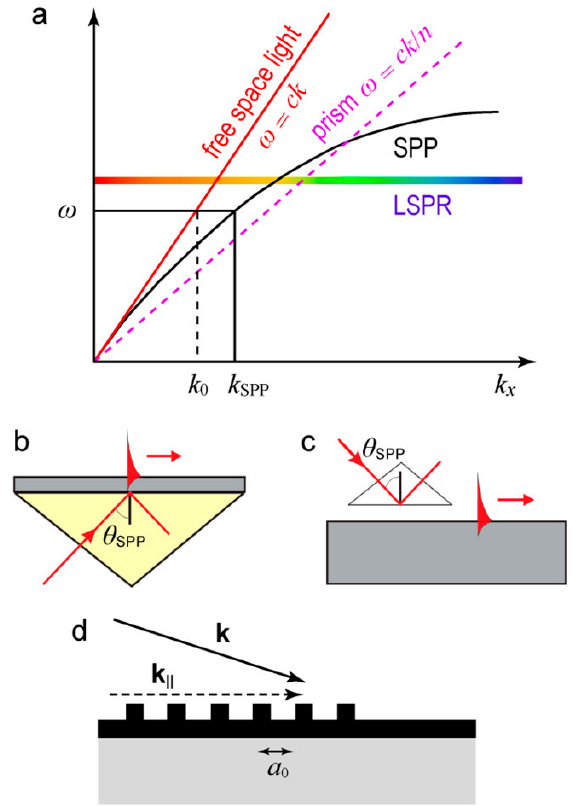
Figure 2. ( a ) Dispersion curves for SPP along metal/free space interface (black curve), light in free space (red curve) and prism material (pink dashed curve); ( b ) Kretschmann; ( c ) Otto and ( d ) grating coupling method. Adapted from [55], with permission © 2017 American Chemical Society.